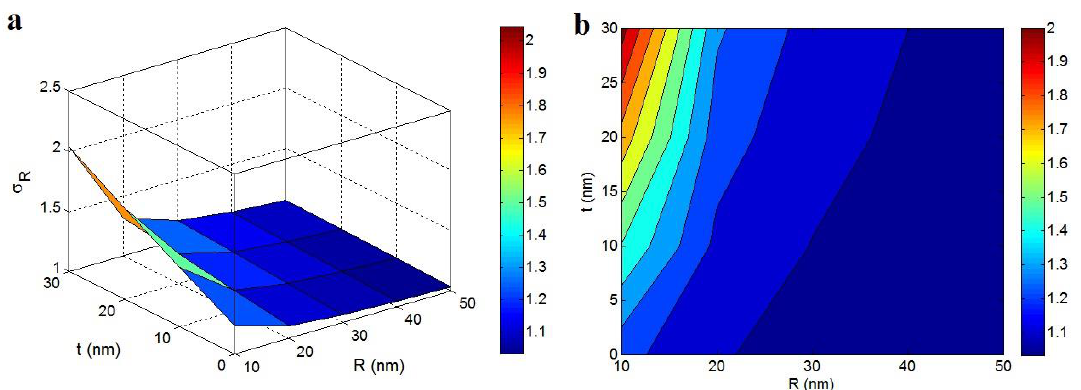
Figure 6. ( a ) 3D and ( b ) contour schemes for the influences of “ R ” and “ t ” on the relative strength expending the Callister model ( σ m = 40 MPa, φ f = 0.02, s = 1 MPa and l = 5 µ m).